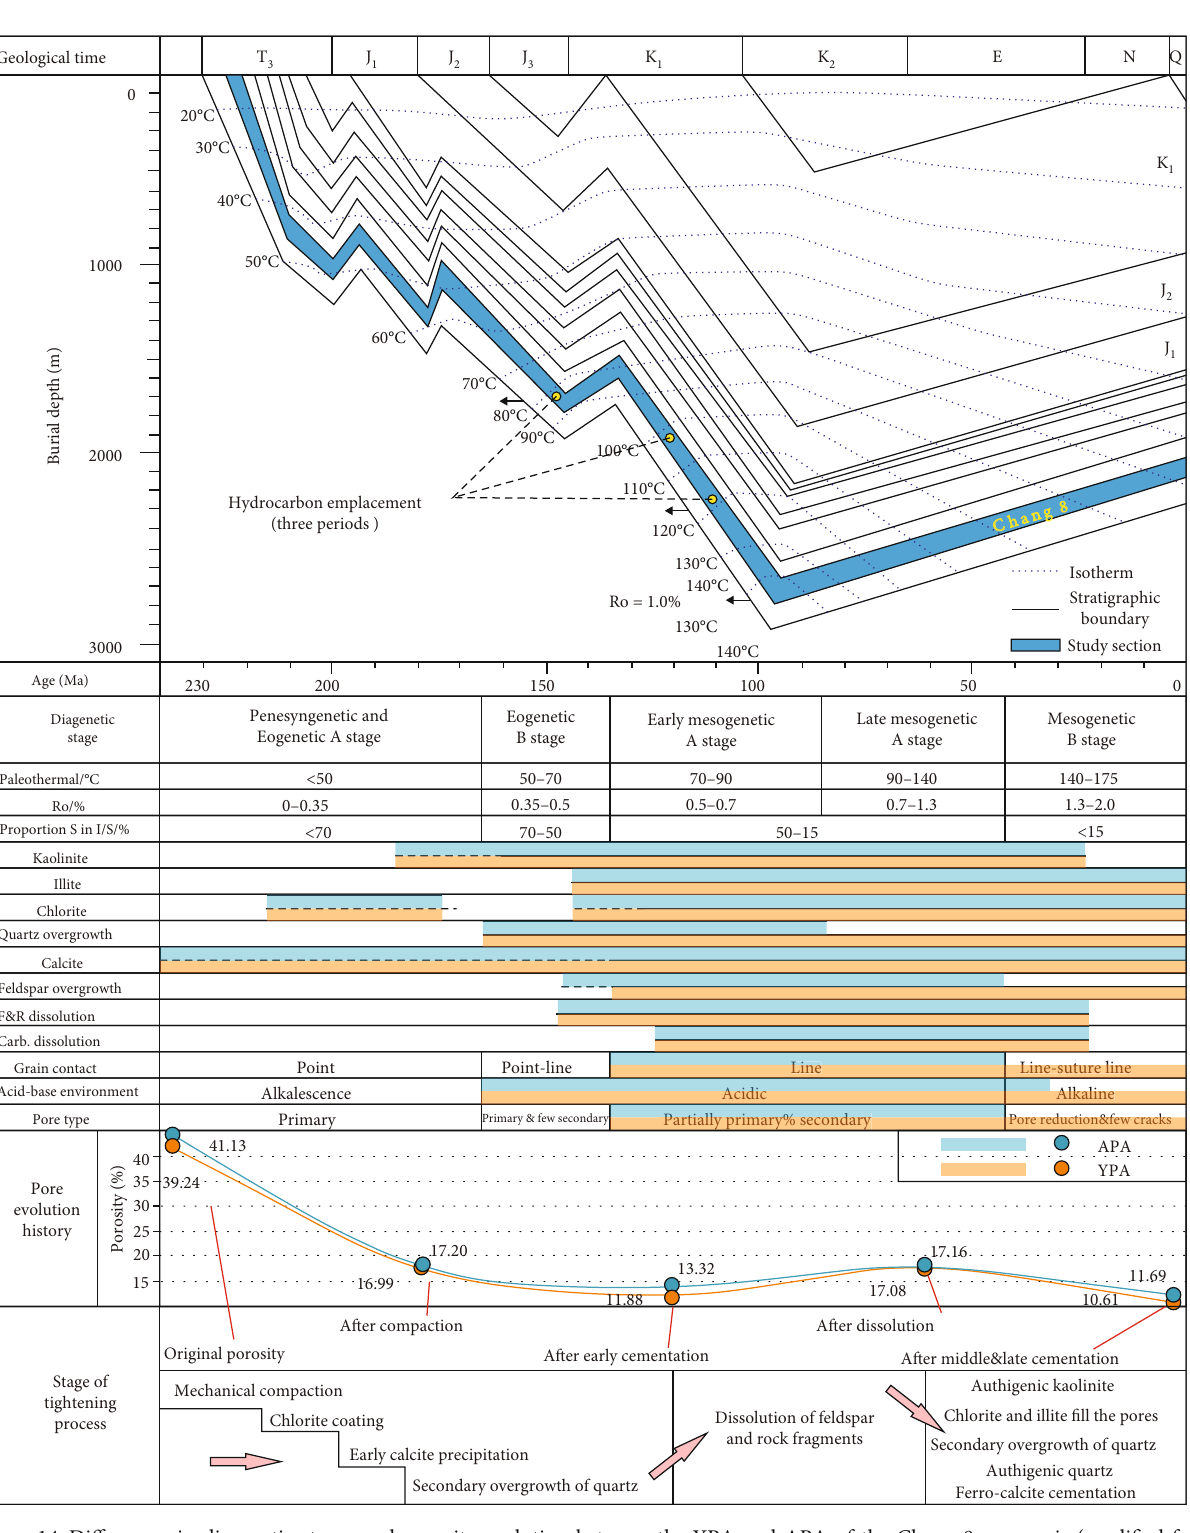
reservoir (modi fi ed from 2